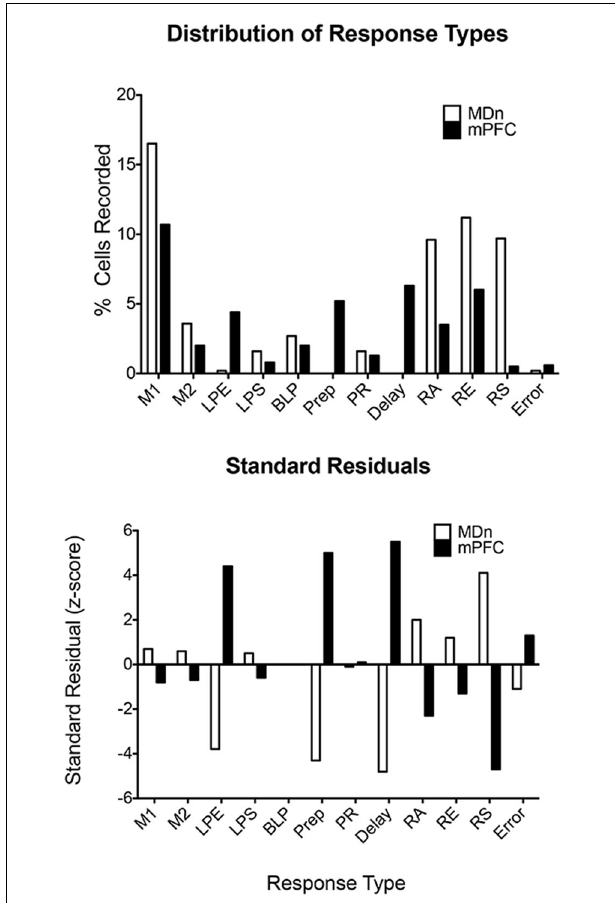
FIGURE 11 | Distribution of response types observed in the mediodorsal thalamic nucleus (MDn) and mPFC during the dDNMTP task. Standard residuals indicate the contributions of each response type to the significant chi-square comparing the distribution of different response types in MDn and mPFC. Results are shown for movement 1 (M1) and 2 (M2), lever press excitation (LPE) and suppression (LPS), base lever press (BLP), preparation (Prep), post-reinforcement (PR), error (E), and reinforcement anticipation (RA), excitation (RE), and suppression (RS). The figure is reproduced from Miller et al.